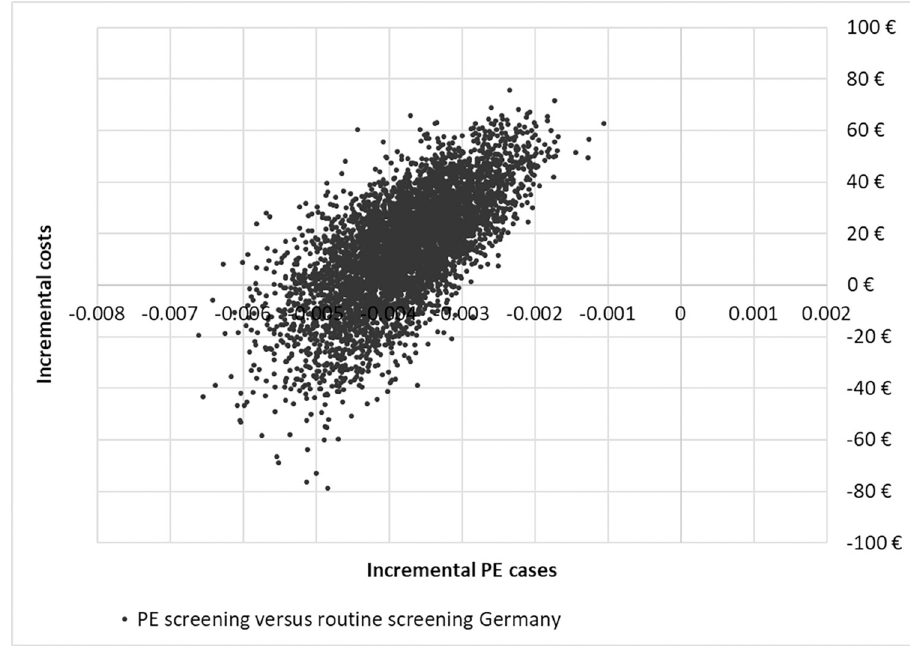
Fig 4. Cost-effectiveness plane Germany.